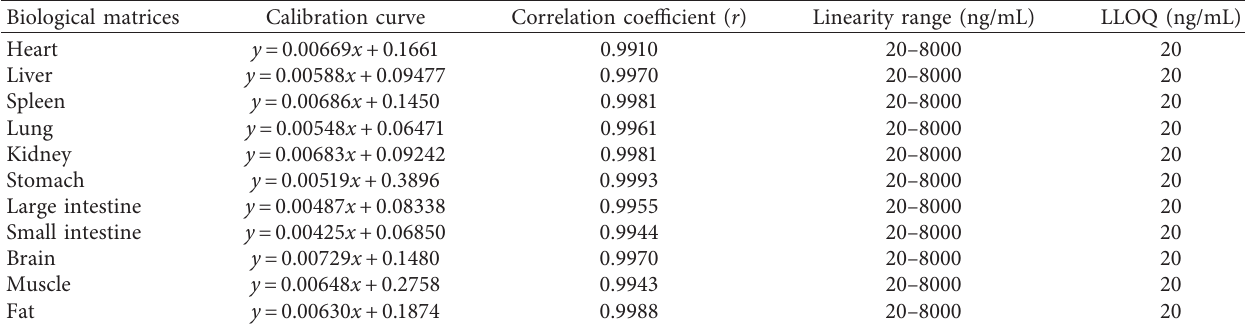
Table 2: Standard curves of crizotinib in different biological matrices.